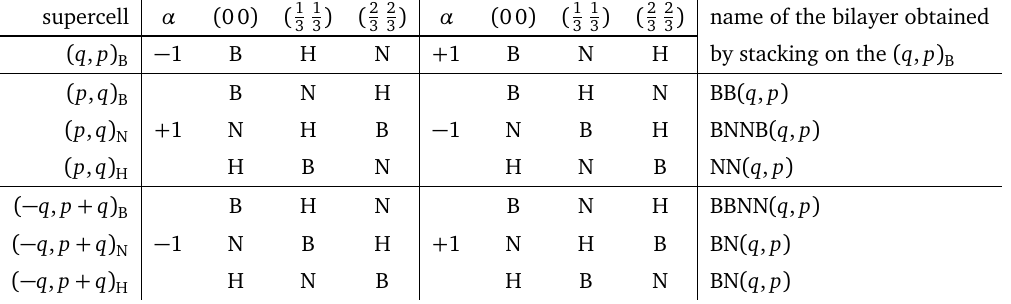
Table 4: Determination of the kind of the sublattices located at the high symmetry points used in our construction of bilayers for a generic { p , q } pair, and the name of the resulting